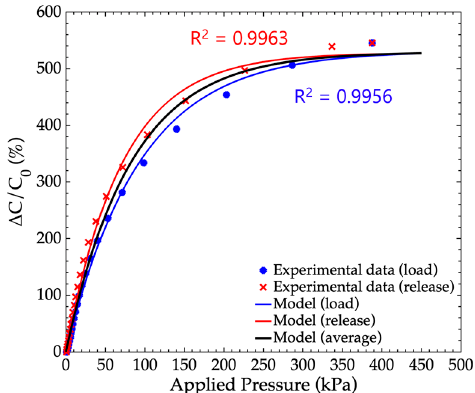
Figure 5. Typical response curve for a sensor featuring 4:1 small pore PDMS foam. Experimental data obtained during a load cycle (blue dots) and an adjusted load model (blue line) and a release cycle (red cross) with an adjusted release model (red line). Average load and release model is represented by the black line.